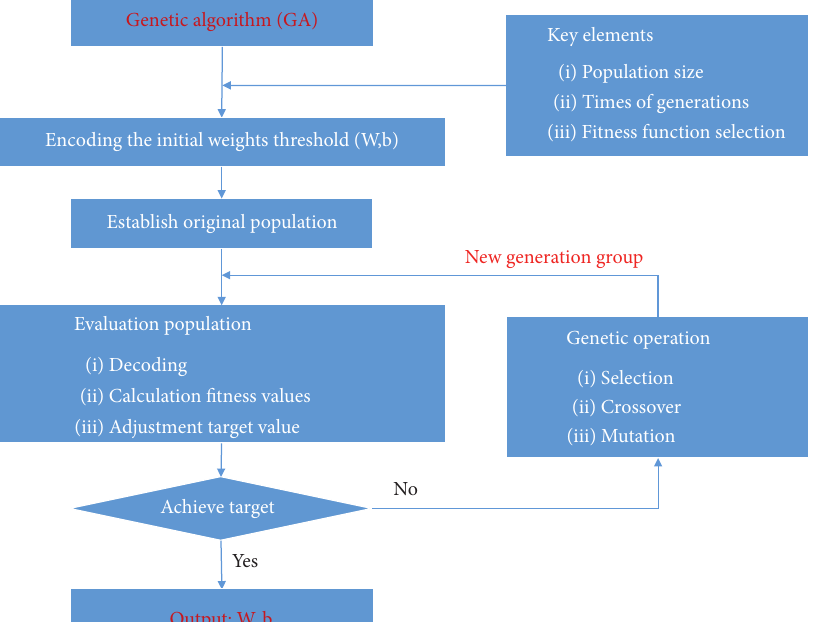
Figure 5: The working principle of GA in the optimal procedure.